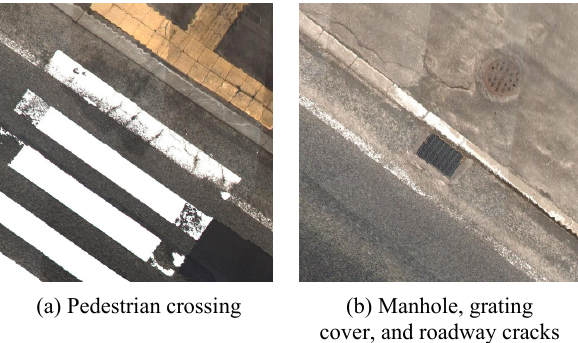
Figure 13. Enlarged image of 1cm ground resolution ORI